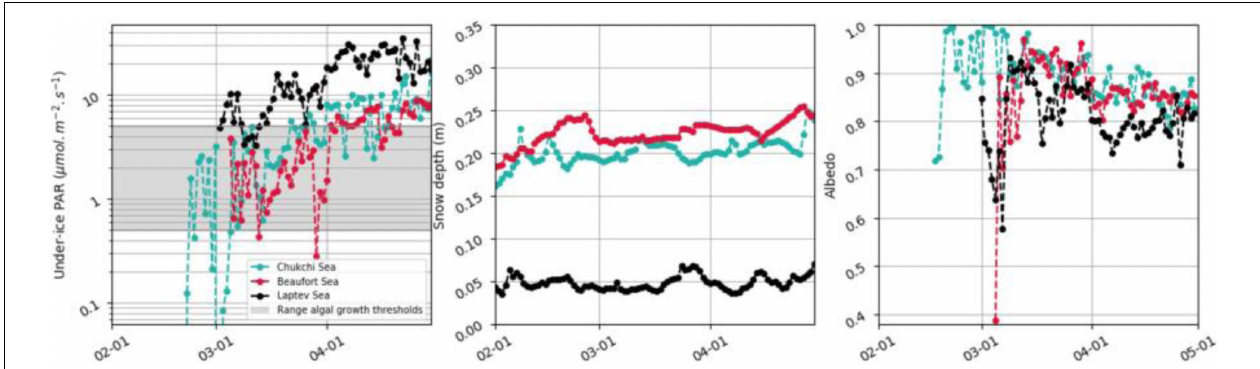
FIGURE 10 | Daily retrieval of the under-ice PAR using daily evolutions of the physical parameters starting on February 1 2012. Parameters shown are the snow depth and the albedo. Three locations are evaluated for a 5 × 5 pixel area around each center location: Chukchi (72.97N/ − 171.29E), Beaufort (78.45N/ − 150.23E), and Laptev (77.09N/119.79E) seas. Gray shading corresponds to range of thresholds for algal growth (0.5–5 µ mol m − 2 s − 1 ).